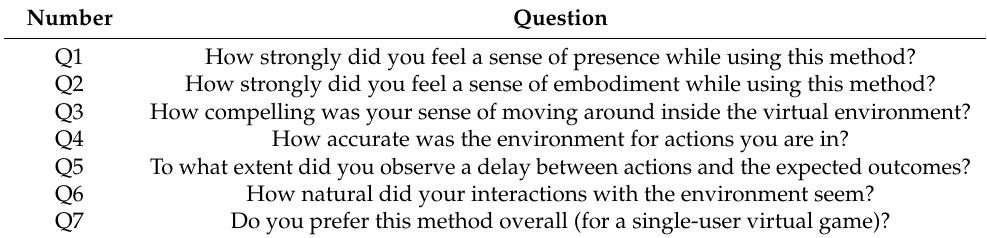
Figure 10. Ball-grabbing game in two modes. Camera view of three users ( bottom ) playing the ball-grabbing game using our method ( top ) and the IK method ( middle ). Table 7. Questionnaire for the archery game.